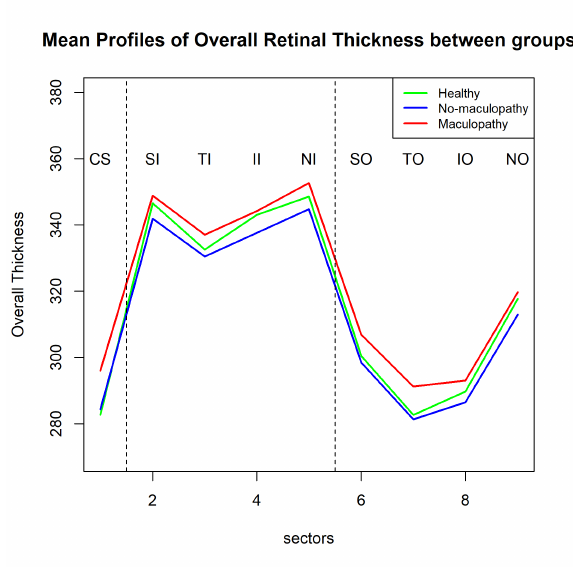
Figure 4. Visualizations for mean profiles of retinal overall thickness over the nine sectors in the ETDRS grid between the three groups (healthy, eyes with maculopathy and eyes without maculopathy). The green, blue, and red lines represent healthy eyes, eyes without maculopathy and eyes with maculopathy,